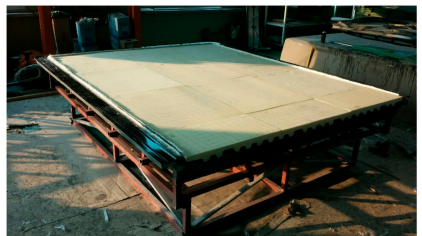
Figure 16. Application of foam core for sandwich composite